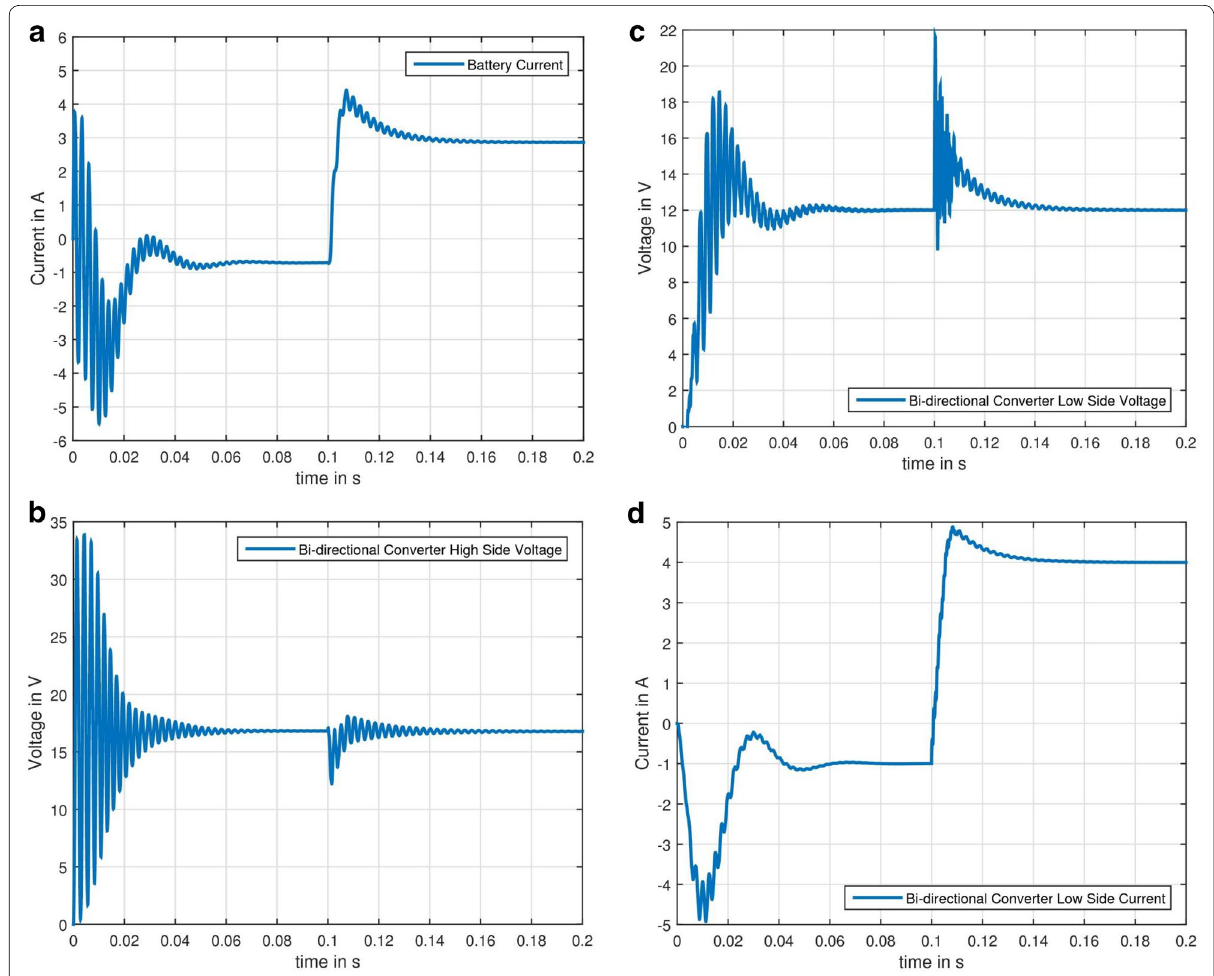
Fig. 7 a BDC high side current input during charging (negative) and output while discharging (positive). b BDC high side voltage. c BDC low side voltage. d BDC low side current input during charging (negative) and output while discharging